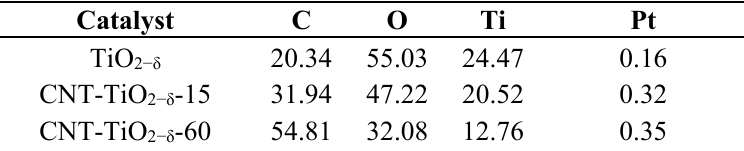
Table 2. Surface compositions (in atomic percent, at%) of the photocatalysts after reactions derived from the quantitative XPS studies. Platinum (0.1 wt%) was photodeposited as the co-catalyst. Catalyst C